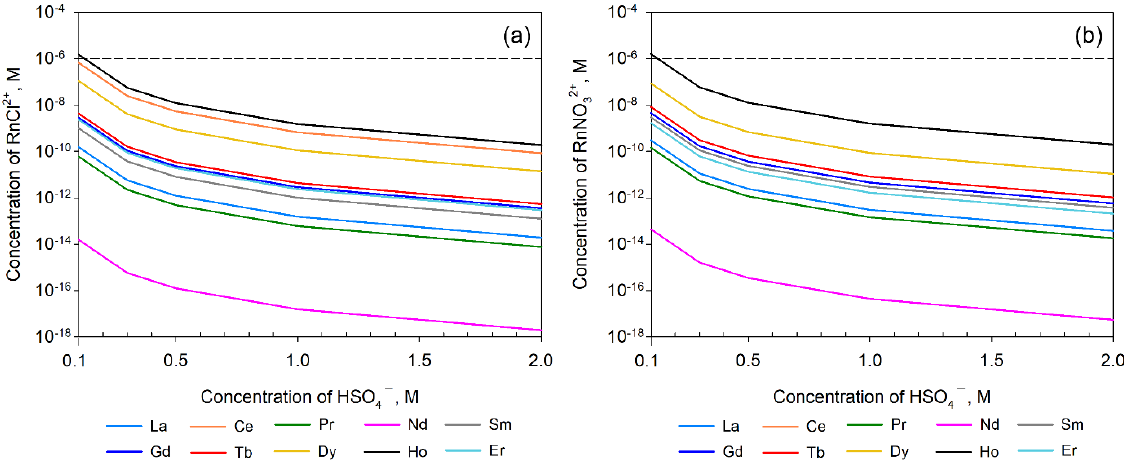
Table 4. Concentrations of RnCl 2+ or RnNO 32+ in equilibrium with sodium double salt at pH 1.